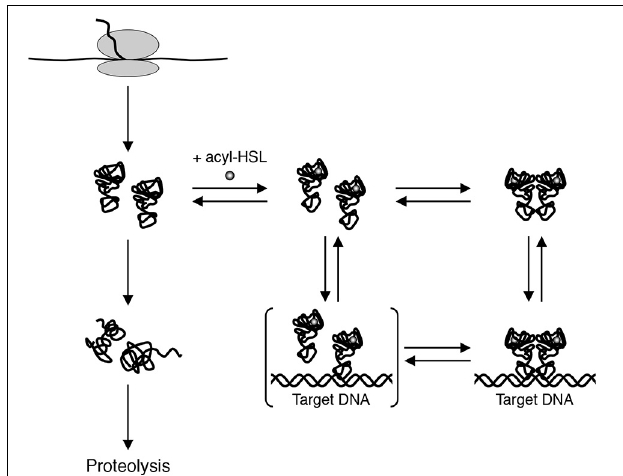
FIGURE 3 | A model for biochemical states of QscR in vivo . Nascent QscR polypeptides can fold into active forms and exist as monomers at low concentrations. The monomers can either refold into inactive forms that are subsequently proteolyzed or they can bind AHLs and form homodimers capable of binding target DNA from Oinuma and Greenberg